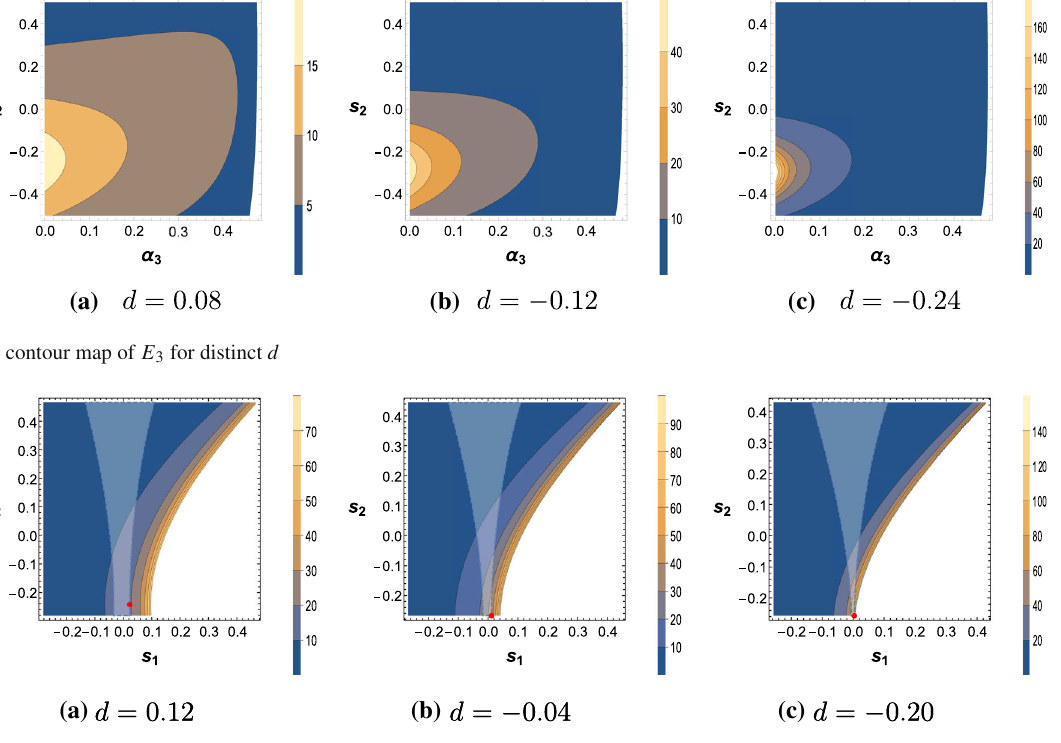
Fig. 5 E 3 as the function of s 1 and s 2 under the time-like condition. The point with maximal E 3 is marked in red in the contour map